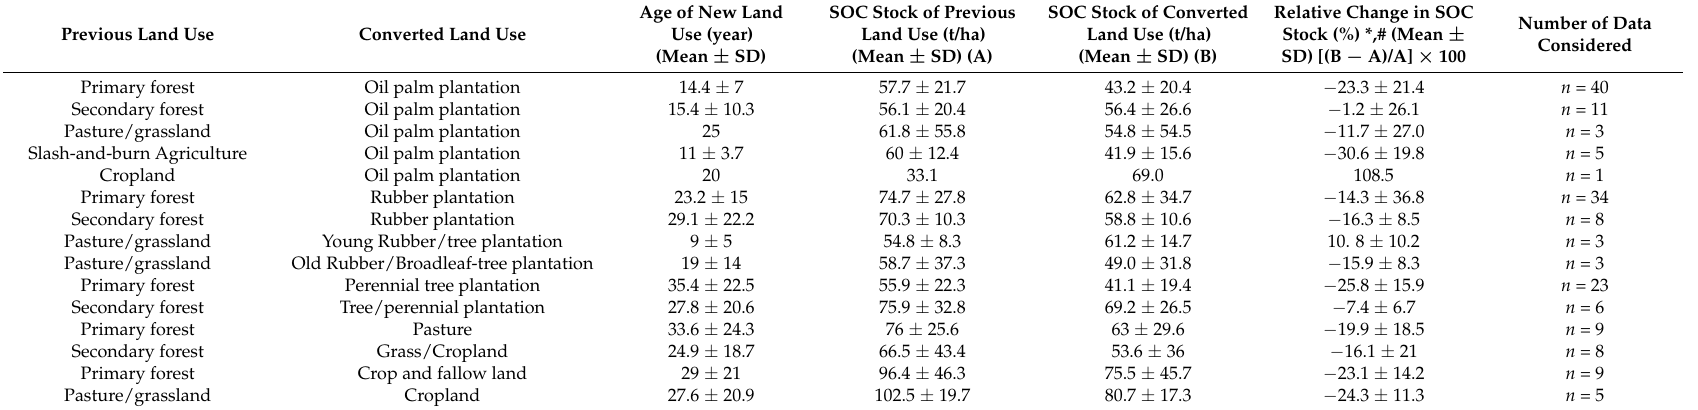
Table 1. Summary of relative SOC stock change from different land use changes (data source cited in Tables